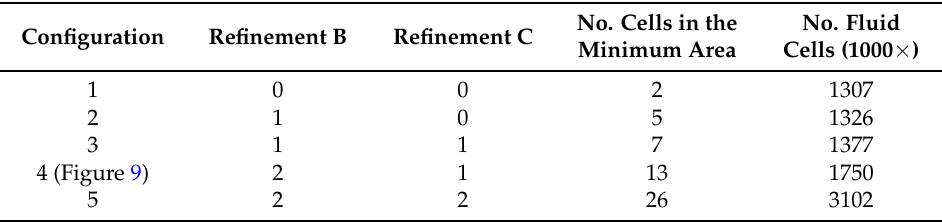
Table 2. Configurations used for the local refinement of the mesh.